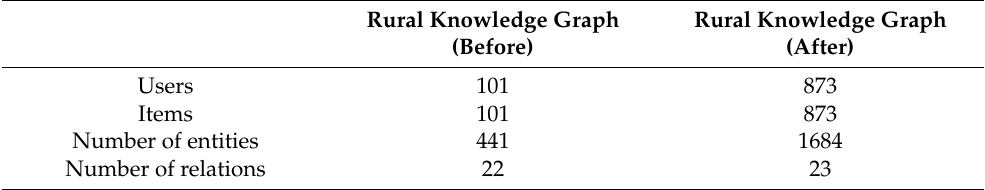
Table 7. Data scale comparison of the rural knowledge graph before and after